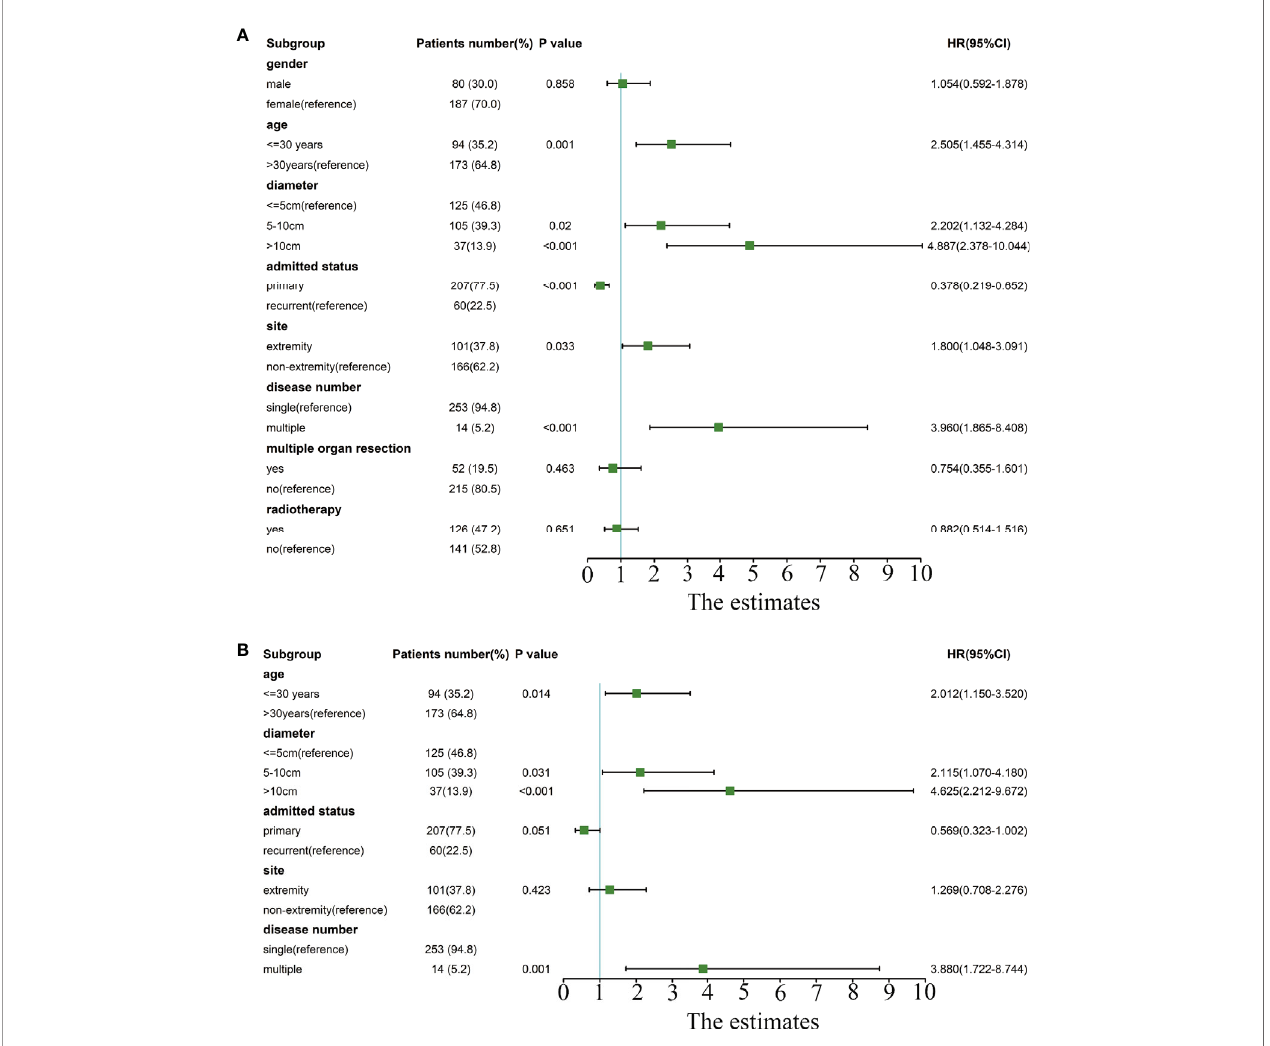
FIGURE 2 | Forest plot of univariate and multivariate Cox analyses of risk factors related to recurrence. (A) The forest plot for univariate Cox analysis. (B) The forest plot for multivariate Cox analysis.